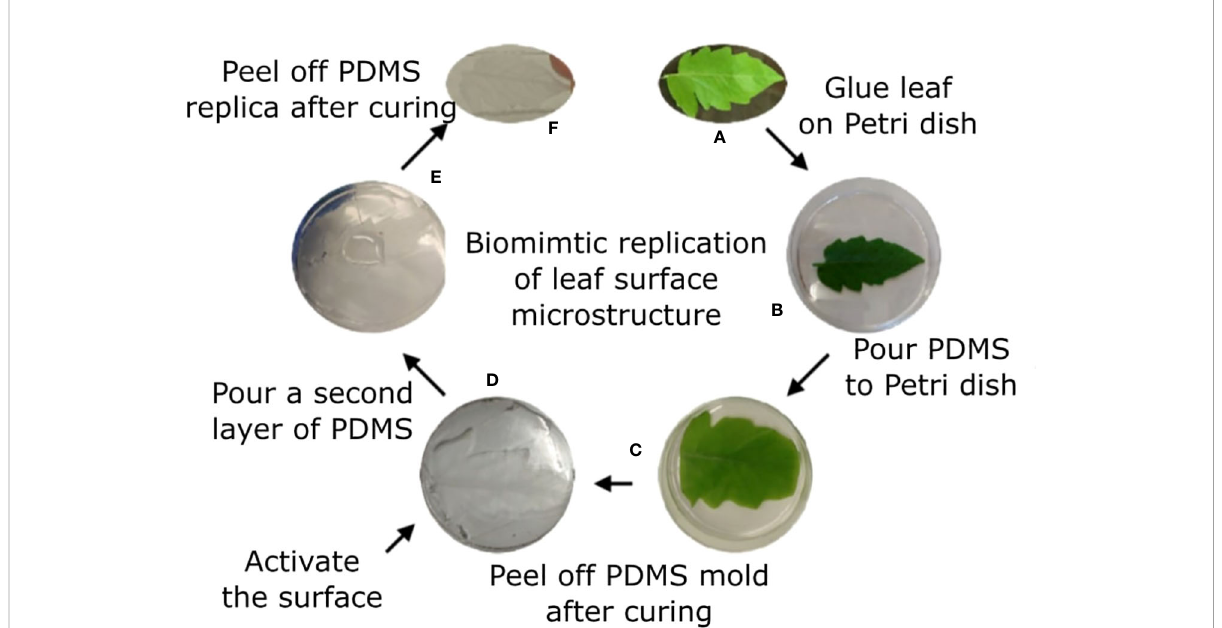
FIGURE 1 Tomato leaf replication process. Tomato leaf (A) is glued on a Petri dish with the abaxial side facing up (B) . Liquid PDMS is poured on top of the leaf (C) and cured overnight. The leaf is peeled off the surface, generating a negative replication of the leaf surface, and the surface is activated using plasma (D) . A second layer of PDMS is poured on the negative replica (E) and cured for 30 min. The two layers are separated, and the positive replica is now visible on the later polymer (F)